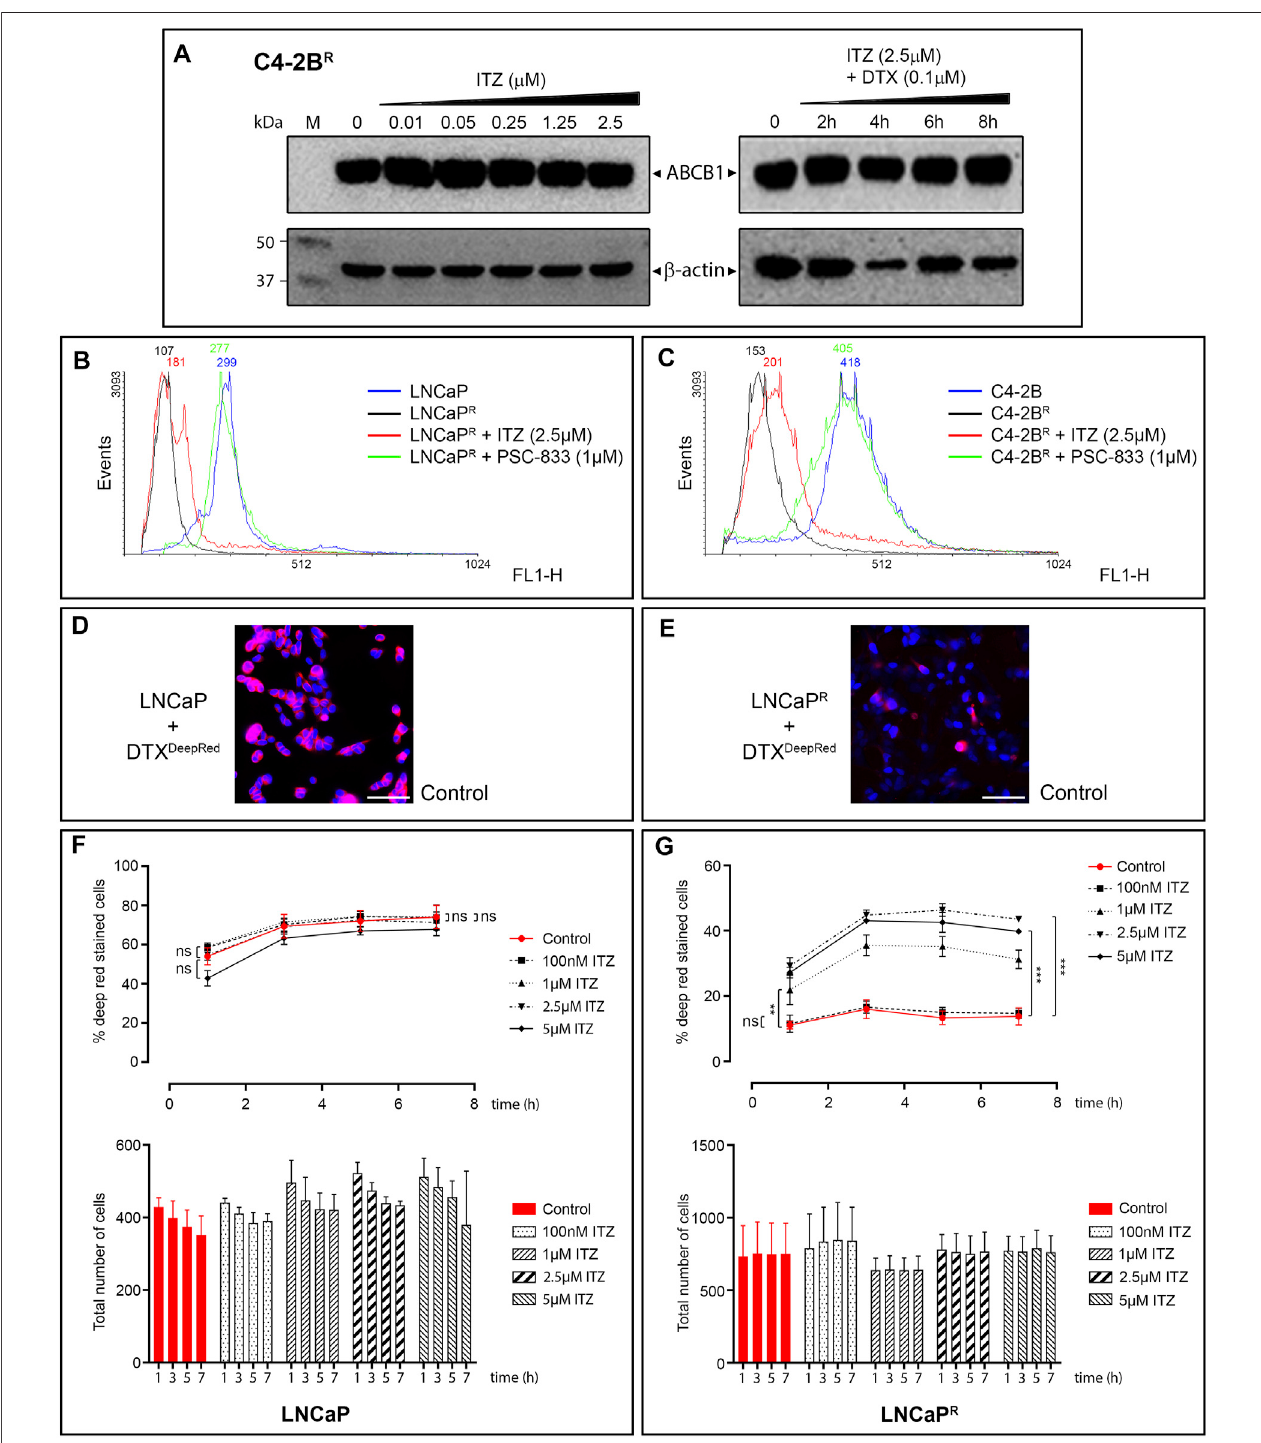
FIGURE4| ExpressionofABCB1and invitro modulationofABCB1-dependentef fl uxofDTX. (A) ABCB1expressionlevelsinC4-2B R cells.ABCB1expressionon total protein cellular extracts was assessed by Western blot analysis using β -actin expression as normalization factor. ABCB1 expression was evaluated after a 48 h exposure to increasing concentrations of ITZ (left panel) and after a combined treatment with ITZ (2.5 µM) and DTX (100 nM) for up to 8 h (right panel). We found no signi fi canteffectofITZonABCB1expressionundertheseconditions.TheeffectofITZonRho123ef fl uxin (B) LNCaP R and (C) C4-2B R cellswasanalysedbyFACS analysis. Fluorescence histograms ofRho123 accumulation are shown after exposure to ITZ (red line), or tothe ABCB1 inhibitorPSC-833 (green line).Levels of Rho123 are also shown for untreated cells (black line) and the non-resistant cell line (blue line). Single-cell in vivo imaging of drug resistant (D) LNCaP and (E) LNCaP R cells